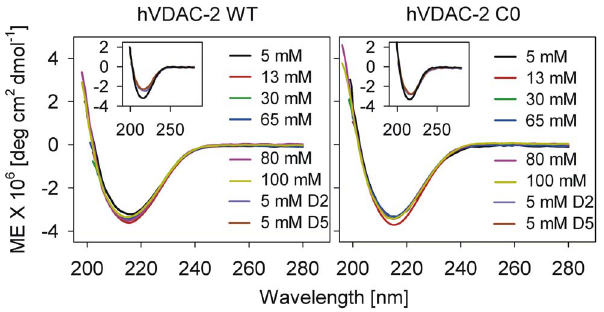
Figure 2. Representative far-UV circular dichroism profiles of refolded hVDAC-2 WT and C0 with increasing LDAOconcentra- tions. Both WT (left) and C0 (right) display CD spectra corresponding to an extended conformation, with a negative maximum at , 215 nm. Both proteins exhibit comparable secondary structure content, despite a 20-fold change in the LDAO concentration from 5 mM to 100 mM. The inset shows the CD spectra of control samples prepared by ‘direct’ refolding in LPRs of 2600:1 (5 mM D2) and 1000:1 (5 mM D5), and are compared with ‘refolded’ protein in 5 mM LDAO, also having an LPR of 2600:1. Molar ellipticity (ME) values are lower for the control samples, suggesting the importance of absolute LDAO concentrations to mediate optimal